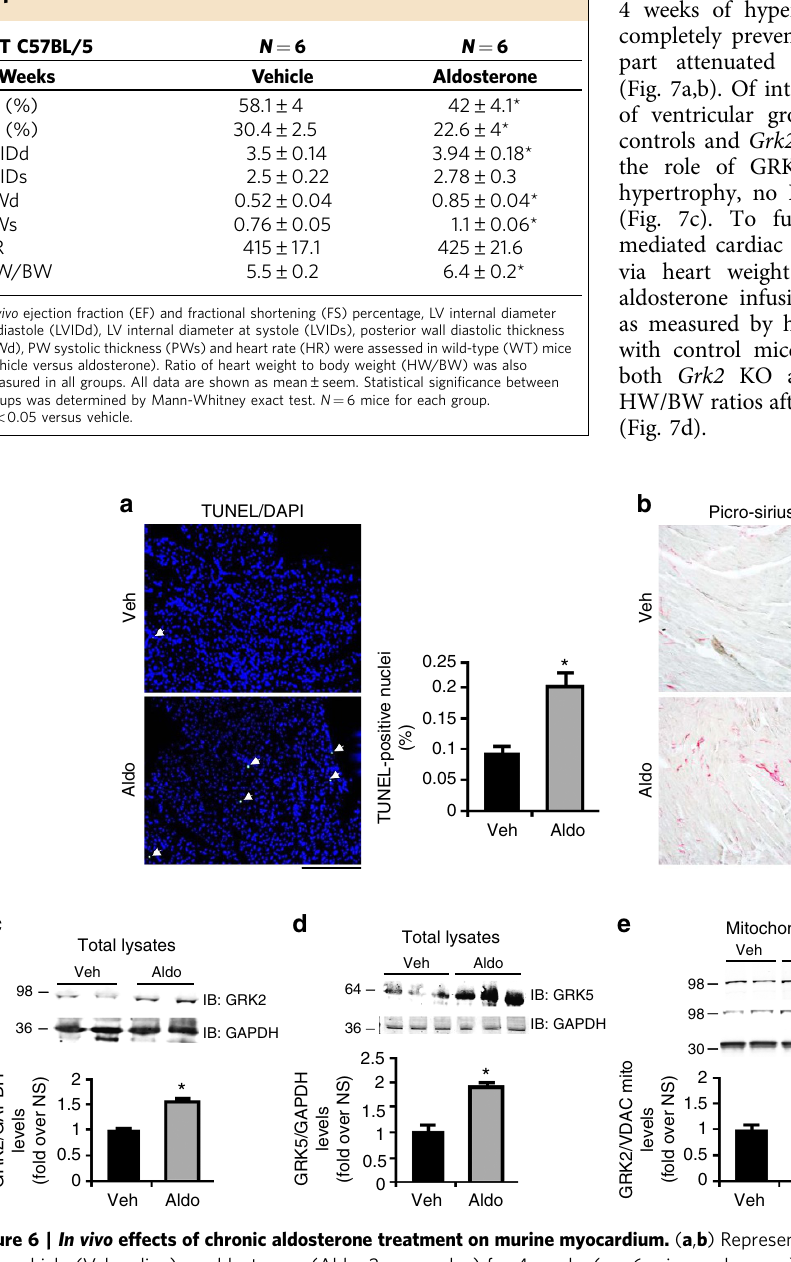
Table 1 | Effect of aldosterone treatment on LV function evaluated by echocardiography at 4 weeks after minipump implantation in WT mice.